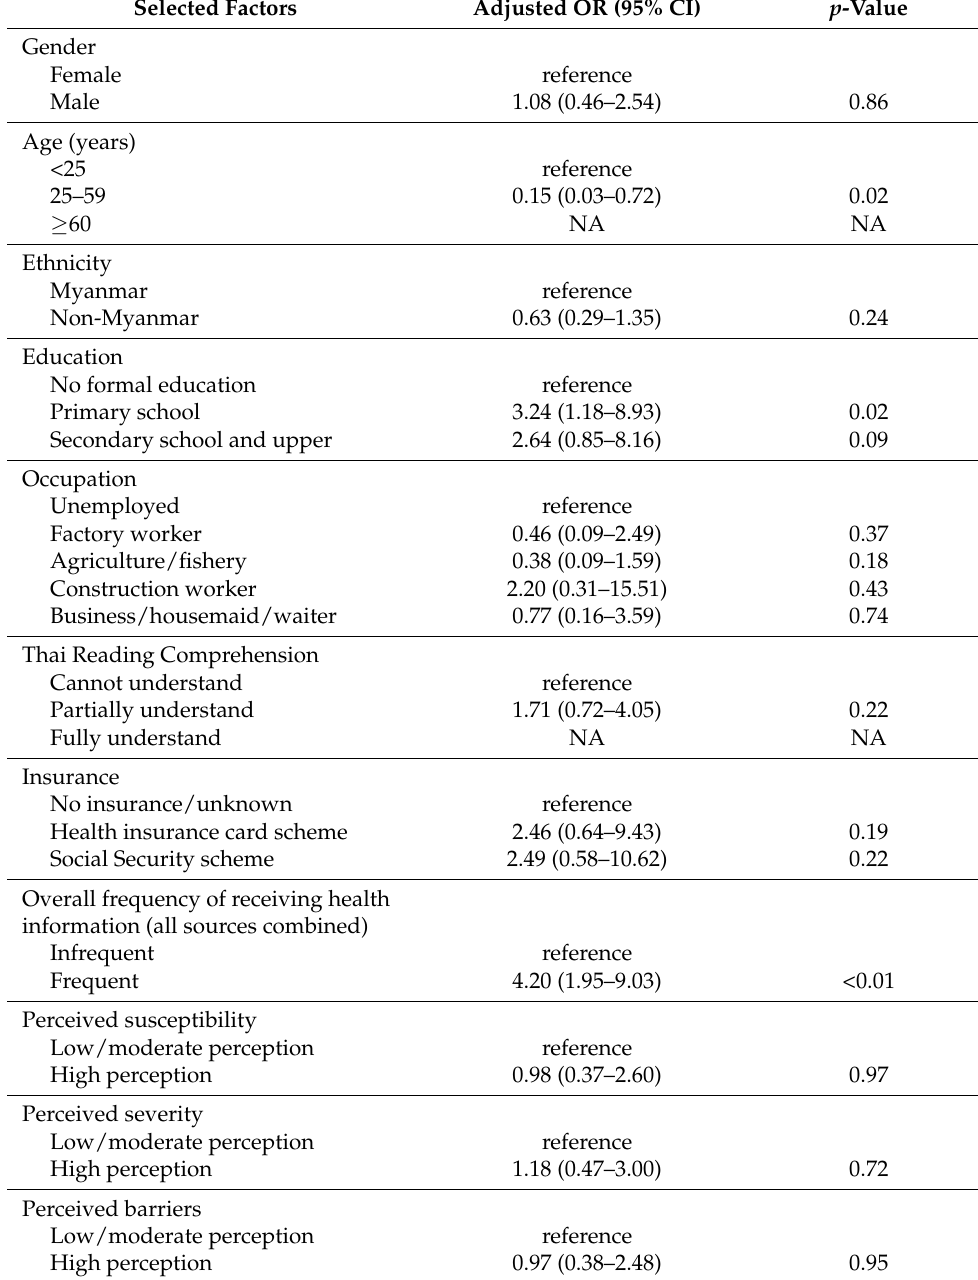
Table 6. Multivariate analysis on self-reported preventive practices during COVID-19. Selected